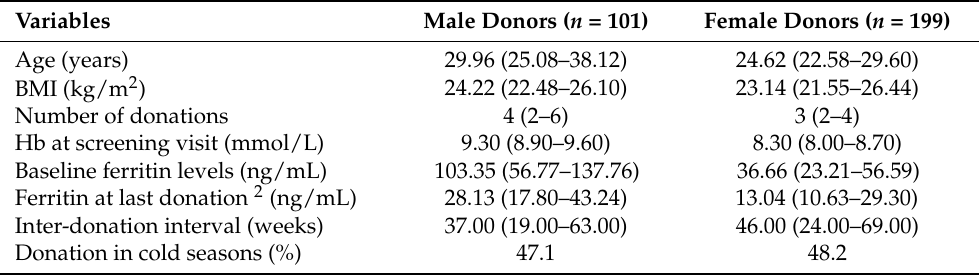
Table 1. Descriptive of donors included in the FIND+ dataset: new whole blood donors with more than two blood donations between September 2017 and September 2019 1